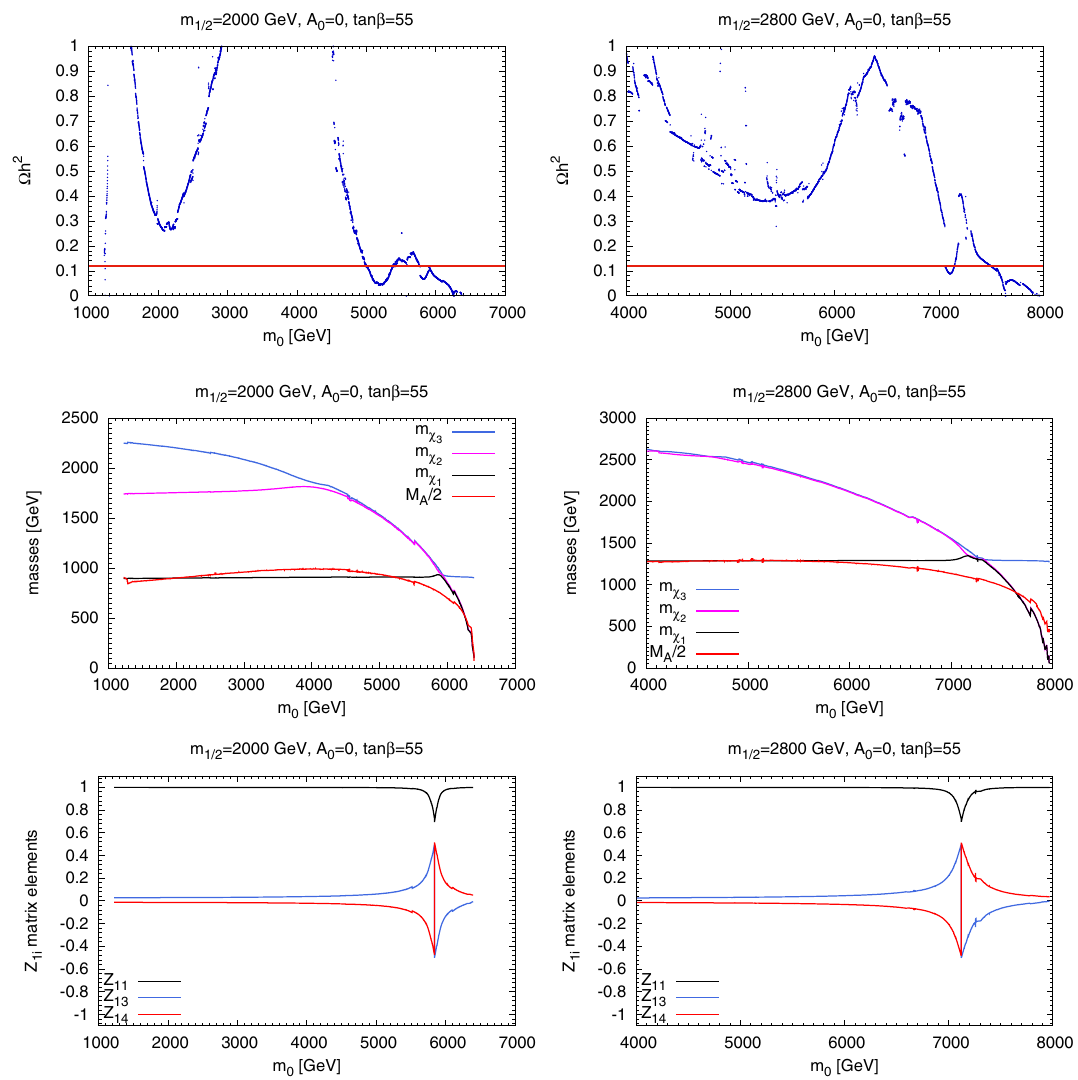
Fig. 4 Cuts across the ( m 1 / 2 , m 0 ) planes for tan β = 55, A 0 = 0 and μ > 0 for varying m 0 and fixed m 1 / 2 = 2 . 0 TeV (left panels) and 2 . 8 TeV (right panels), showing the dark matter density (top panels), particle masses (middle panels) and the composition of the LSP (bottom panels) (cid:5) 2 − 3 m 1 / 2 . On the other hand, as we discuss in